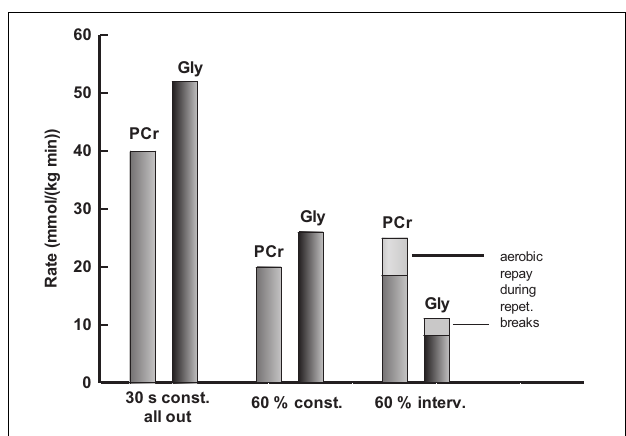
( Table 2 ), the distribution between sources of anaerobic energy is pretty much the opposite of that seen in the WAnT. In highly trained athletes, isometric contractions of ∼ 50% F max led to complete vascular occlusion (Barnes, 1980). Therefore, the above differences, between energetics of WAnT and present in the 30- s all-out test, likely reflect the substantially smaller mass of the and vascular occlusion in the single-handed hanging task, as supported by our metabolic results. With reference to